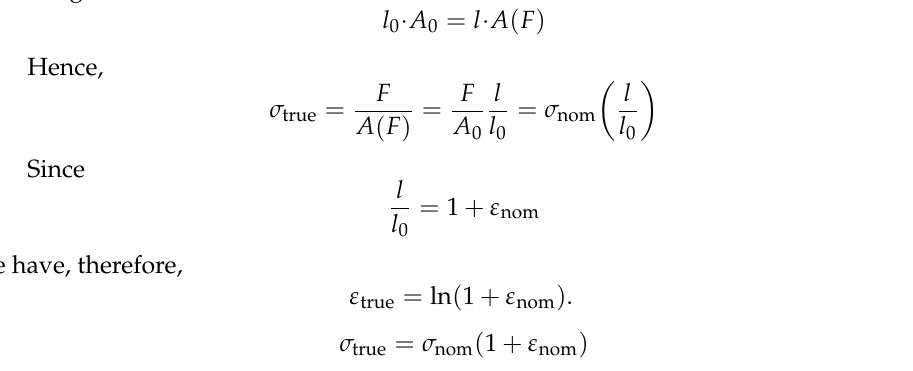
Figure 4. Tensile test results; nominal σ – ε of HY 80 steel, strain rate 𝜀(cid:4662) = 0.0001 𝑠 (cid:2879)(cid:2869) .